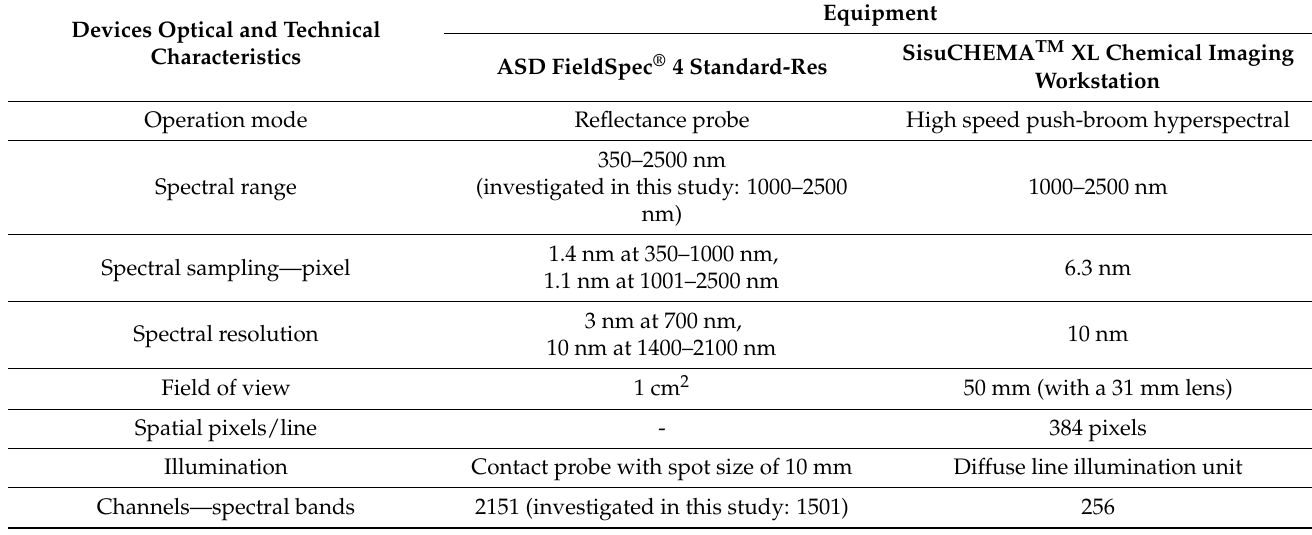
Table 2. ASD FieldSpec ® 4 Standard-Res and SisuCHEMATM XL Chemical Imaging Workstation technical and operative characteristics.